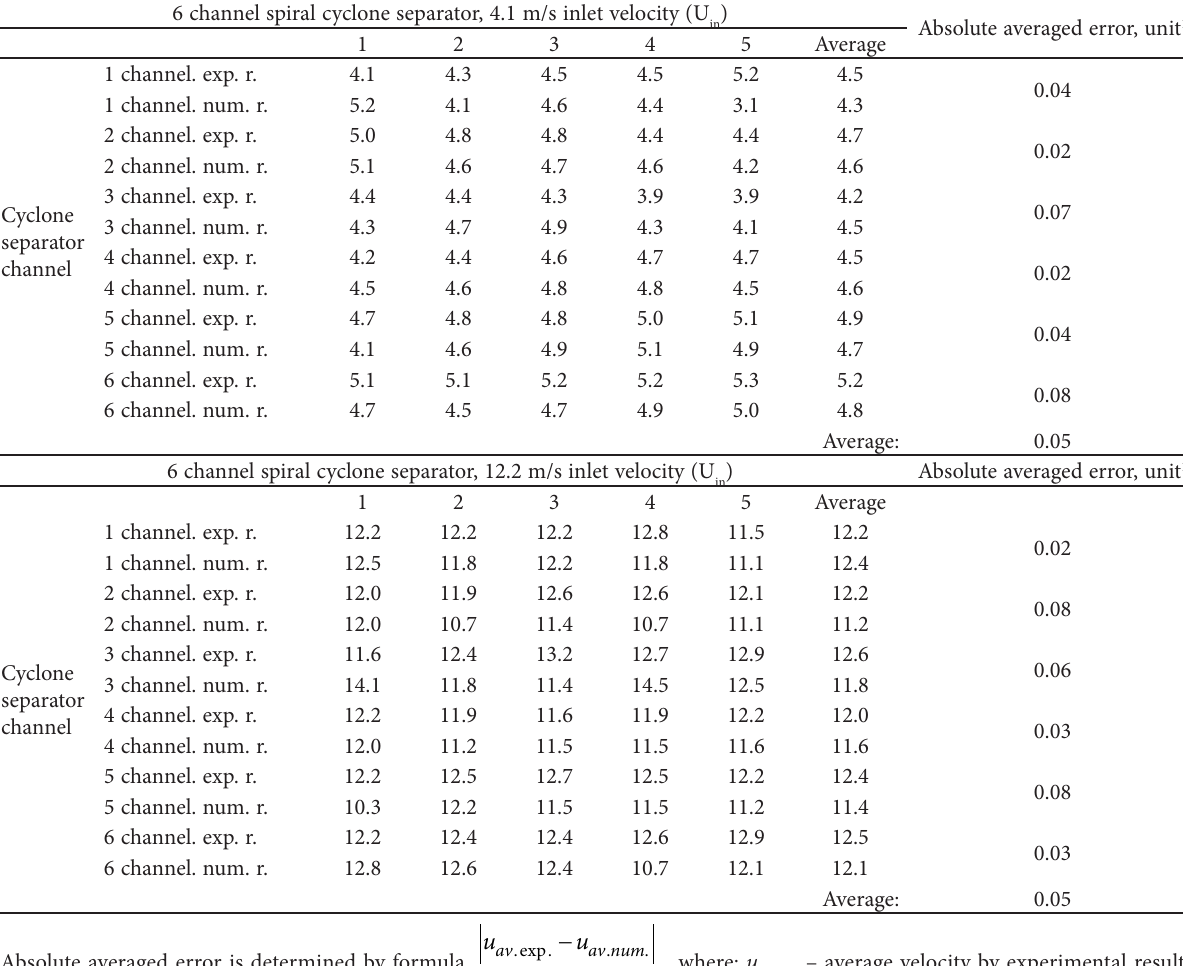
Table 1. Change of the velocity (experimental and modelling) in cyclone separator channels of spiral corps depending on the position and geometry of curvilinear semi-rings ( U 6 channel spiral cyclone separator, 4.1 m/s inlet velocity (U